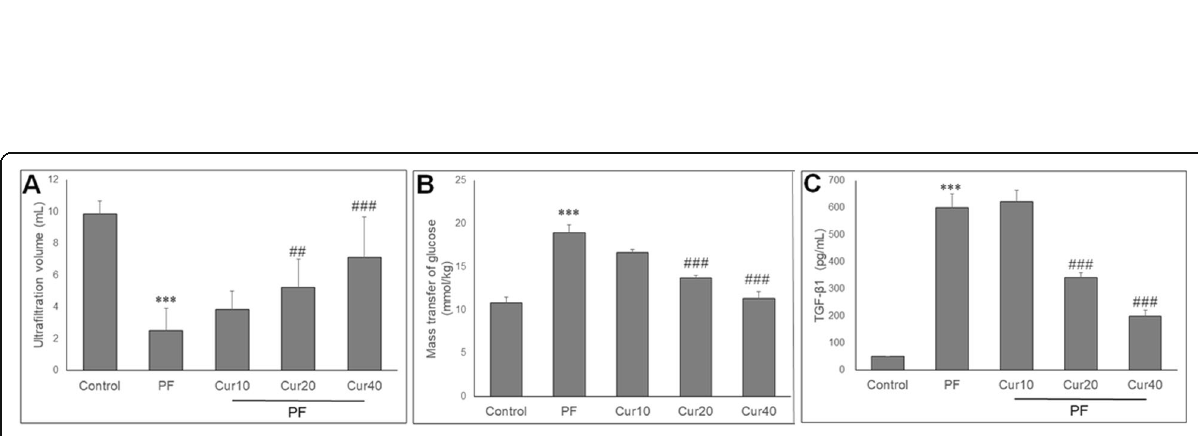
Fig. 2 Effects of Curcumin on peritoneum function and TGF- β 1 content in peritoneal effluence. Curcumin attenuates the decrease in ultrafiltration volume and ( a ) increase in mass transfer of glucose (MTG) ( b ) in PF rats. ELISA showed that compared with control group, PF rats showed significantly higher expression of TGF- β 1 ( c ) in peritoneal effluence, and these changes can be attenuated by curcumin. ANOVA was performed and followed with Tukey ’ s post hoc test. *** P < 0.001 vs. control group; ## P < 0.01, ### P < 0.001 vs. PF